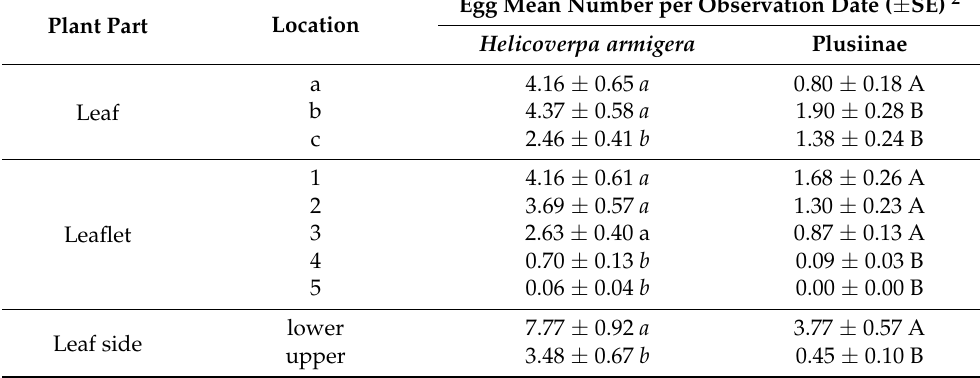
Table 2. Helicoverpa armigera and Plusiinae eggs in processing tomato crops in Ribatejo 1 —comparison among the locations within leaf, leaflet, and leaf surface for tomato fruitworm and Plusiinae 2 (SE— Standard error of the